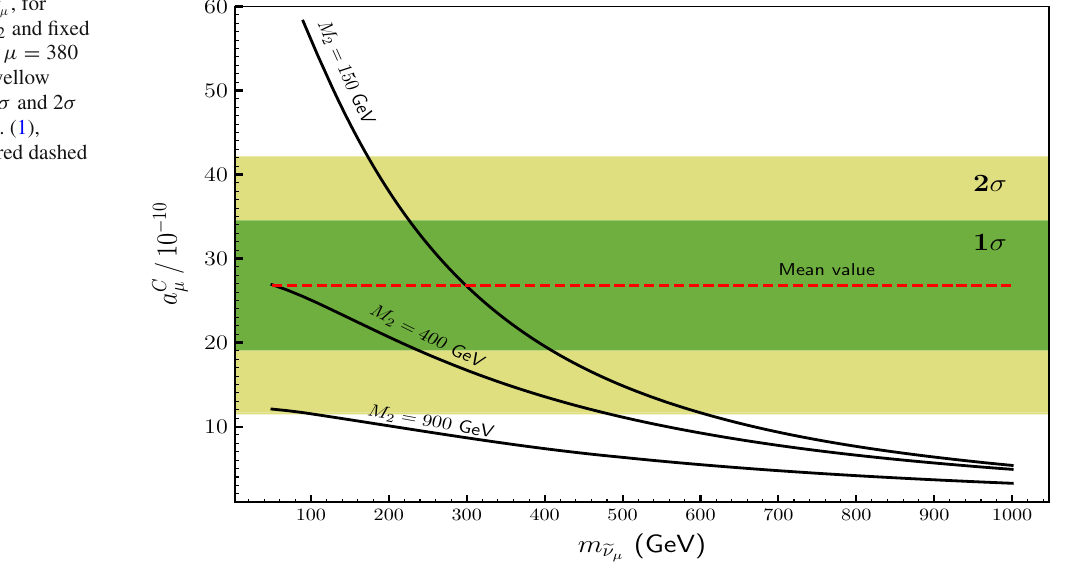
Fig. 2 a C μ versus m (cid:2) ν μ , for different values of M 2 and fixed values of tan β = 14, μ = 380 GeV. The green and yellow bands represent the 1 σ and 2 σ regions of (cid:3) a μ in Eq. (1), respectively, and the red dashed line the mean